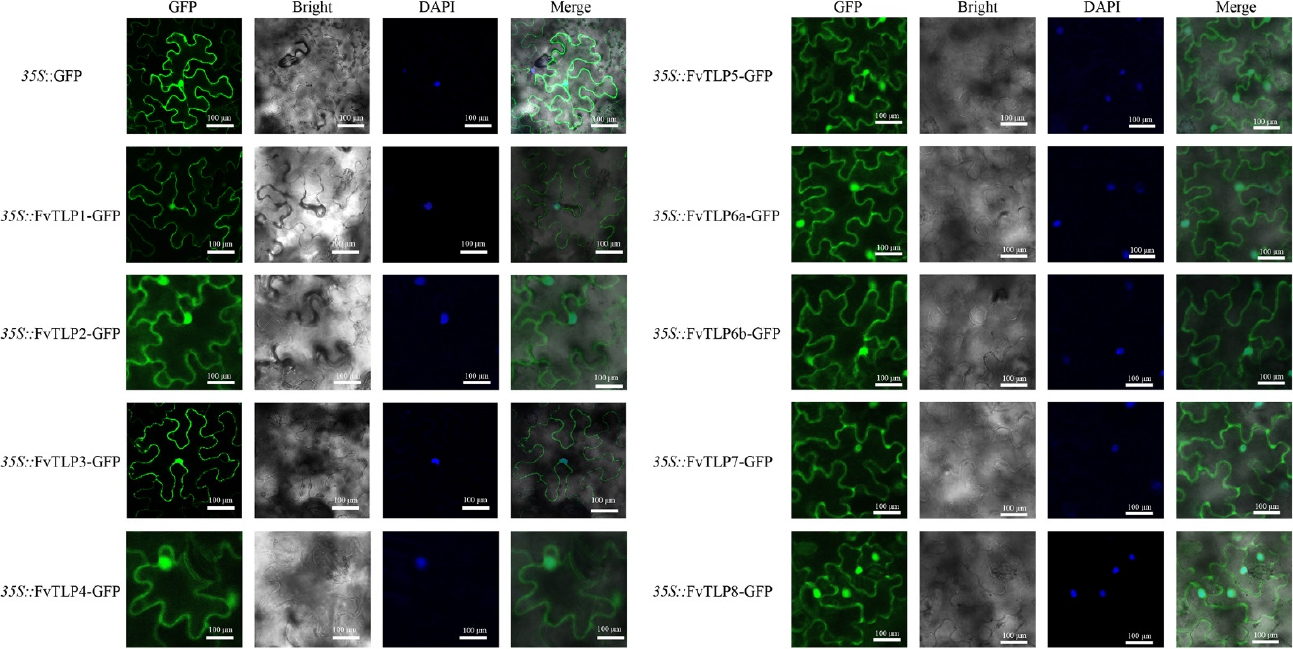
Figure 4. Subcellular localization of FvTLPs. FvTLP-GFP and GFP were transiently expressed in tobacco epidermal cells and then observed with a confocal microscope. Cell nuclei were stained with DAPI.